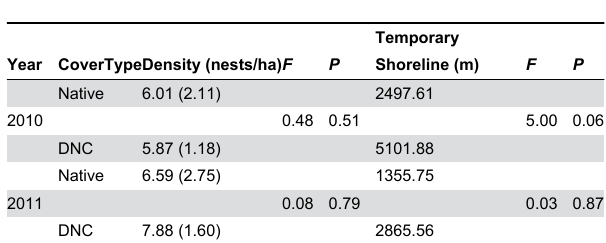
Table 4. Nest density, adjusted for detection probability (SE), amount of temporary shoreline, and mixed model ANOVA results examining effect of cover type on density in 2010-11 in the Devils Lake Wetland Management District, North